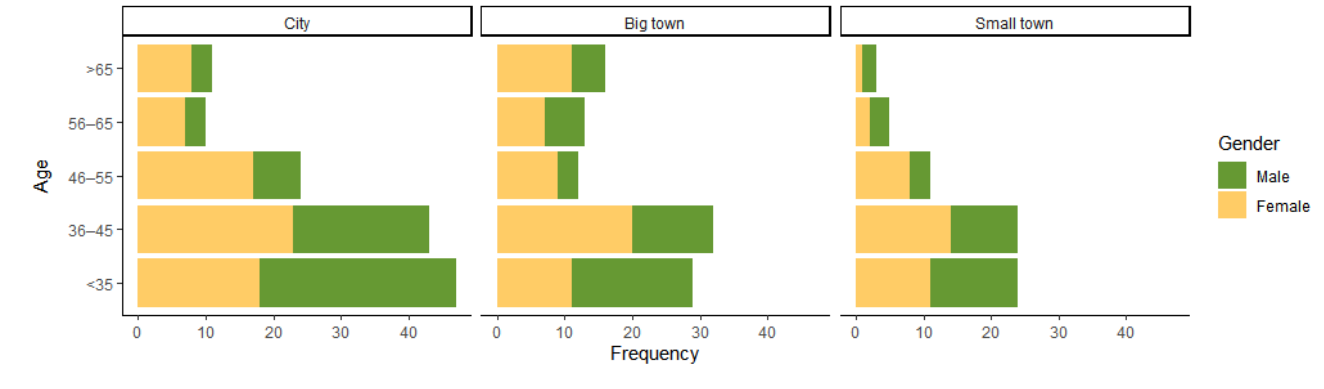
Figure 2. Descriptive statistics of the sample